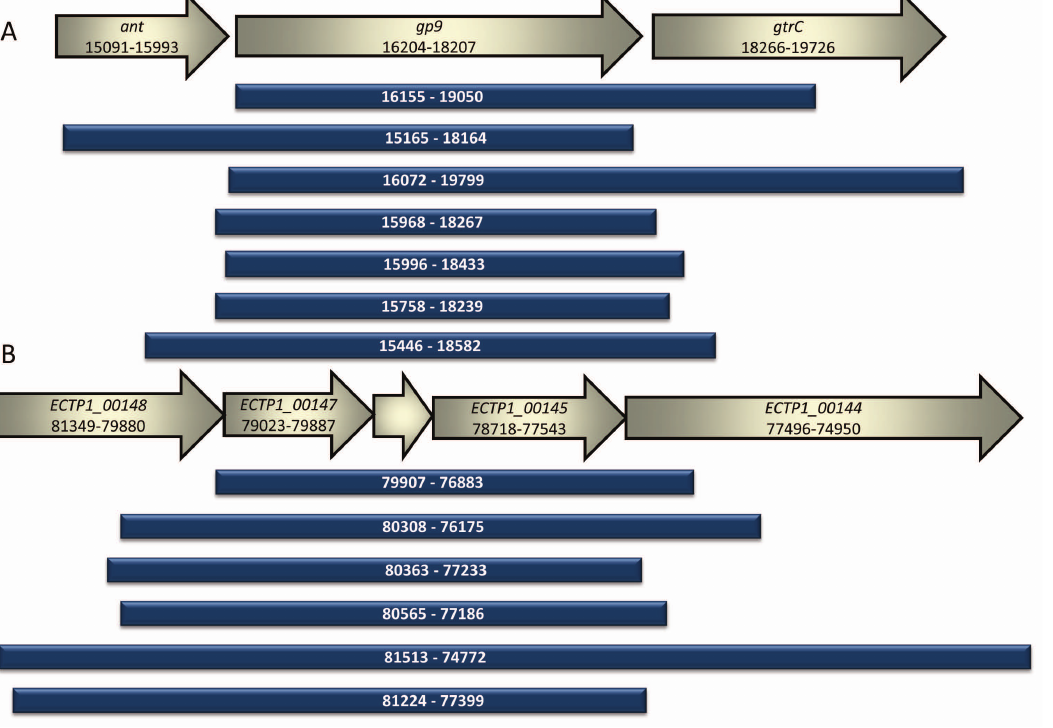
Figure 3. Alignment of sequenced fragments from positive colonies compared to GenBank annotated sequences. ( A ) The inserts identified in this study following screening of the P22 phage genomic library are shown alongside the corresponding portion of the phage P22 genome. Ant encodes the antirepressor associated with the prophage switch from lysogenic to lytic mode, gp9 encodes the